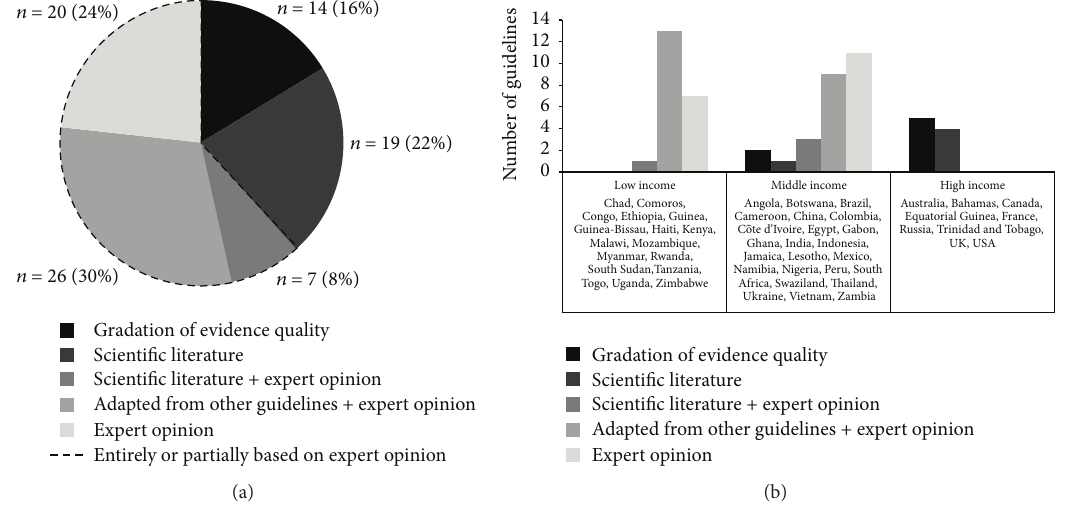
Figure 3: (a) Methodologies used to develop guidelines for HIV-related skin conditions ( 𝑛 = 86 ). (b) Association between gross national income of countries and the methodology used to develop guidelines for HIV-related skin